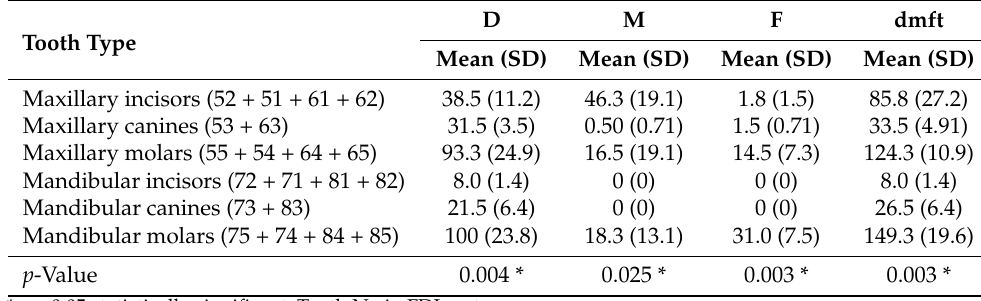
Table 4. The comparison of dmft scores based on tooth type.